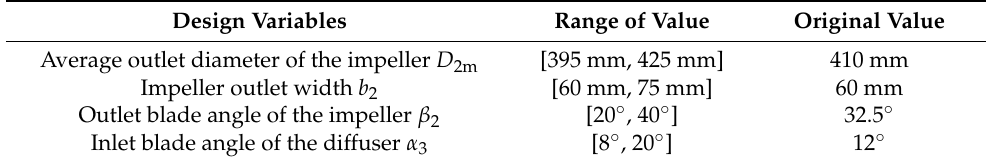
Table 8. Range of values for design